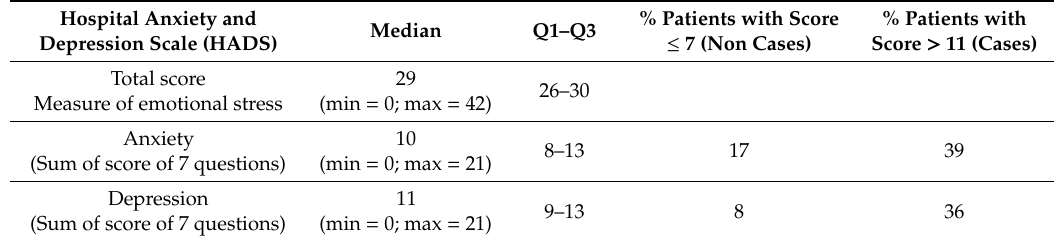
Table 2. Emotional and stressful condition of the interviewees (HADS questionnaire).